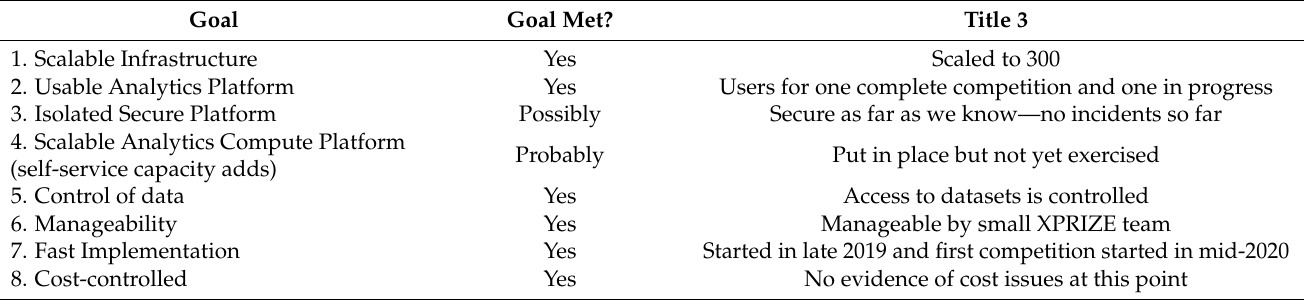
Table 1. Data Collaborative high-level requirements and whether they were